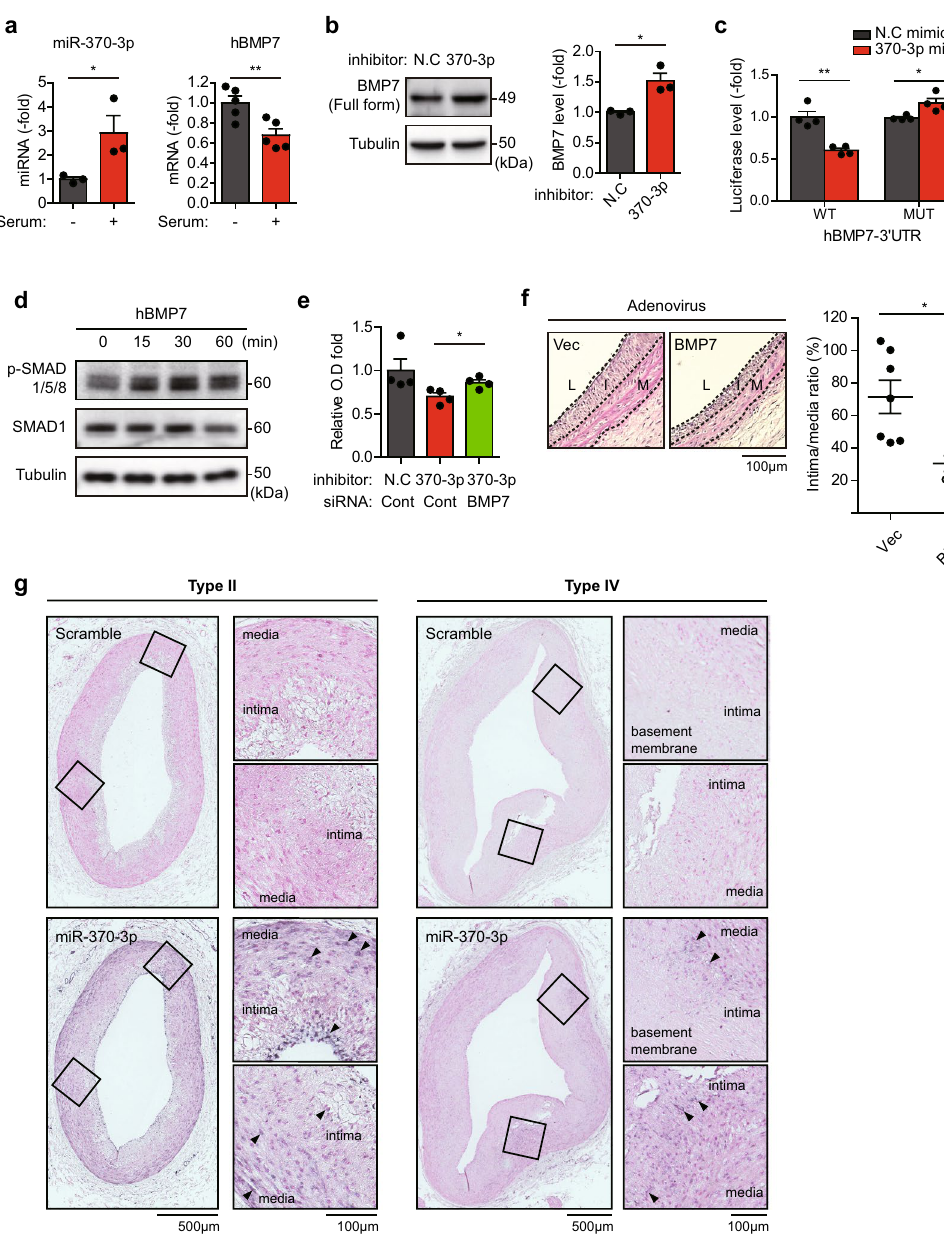
Figure 5. Direct inhibition of BMP-7 expression by miR-370-3p. ( a ) Comparison of miR-370-3p and BMP-7 expressions in the cultured HASMCs. HASMCs were left in the serum-free media or grown in the fetal bovine serum (10%)-containing media for 48 h. Data in graphs are means ± SEM of relative fold changes ( n = 3–5, * P < 0.05, ** P < 0.01). ( b ) Immunoblot analysis of the BMP-7 protein level in the HASMCs transfected with the miR-370-3p inhibitor. A representative immunoblot is shown. Data in the graph are means ± SEM of relative fold change ( n = 3, * P < 0.05). ( c ) Effect of miR-370-3p on the expression of luciferase reporter linked to the 3 ʹ UTR of BMP-7 gene. HEK293T cells were serially-transfected with a firefly luciferase reporter construct containing human BMP-7–3 ʹ UTR region and a miRNA mimic in the indicated combination. Data in graph are means ± SEM of relative luciferase activity compared to non-specific control mimic (N.C) ( n = 4, * P < 0.05, ** P < 0.005). ( d ) BMP-7-induced R-SMAD phosphorylation in the HASMCs. The serum-starved SMCs were treated with human BMP-7 (1 ng/ml). Total SMAD was immunoblotted as a control. A representative immunoblot is shown ( n = 2). ( e ) Effect of BMP-7 on the HASMC proliferation. HASMCs were co-transfected with both siRNA and miRNA inhibitor for 72 h and subjected to the WST-1 assay. Data in graph are means ± SEM of fold changes versus non-specific control (N.C) ( n = 4, * P < 0.05). ( f ) Effects of the adenoviral expression of BMP-7 on the neointimal hyperplasia in the injured rat carotids. The balloon-injured rat carotid vessels were infused with adenoviruses encoding empty or human BMP-7 gene. Representative hematoxylin–eosin (HE) images in the tissue sections of carotid arteries harvested 10 days after injury. Data in the graph are means ± SEM of the intima-to-media ratio ( n = 7–8, * P = 0.0025). L, lumen; I, intima; M, media. Scale bar 100 μm. ( g ) In situ hybridization showing the high expression of miR-370-3p in the neointimal lesions of coronary arteries obtained from human atherosclerotic patients ( filled arrowheads ). Type II and IV indicate the early and advanced disease grades, respectively. Nuclei were counterstained by nuclear fast red. Digoxigenin (DIG)-modified scrambled probe was used as a negative control. The lesion areas for magnification are indicated by rectangles. Scale bar 500 μm and 100